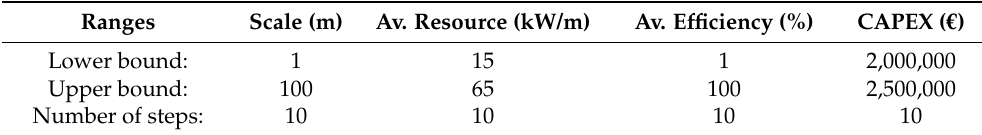
Table 9. Input ranges chosen for the example of a public funder with a specific budget ( € 2-2.5 million) looking for an attractive concept in a resource level of